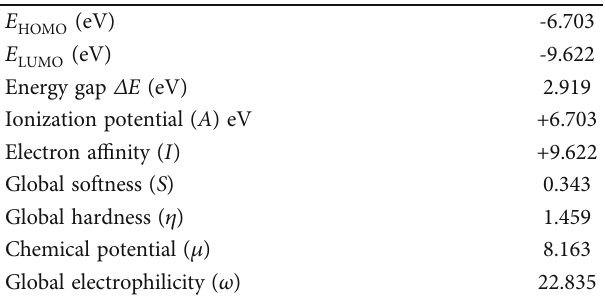
Table 5: The electric dipole moment μ (D). The